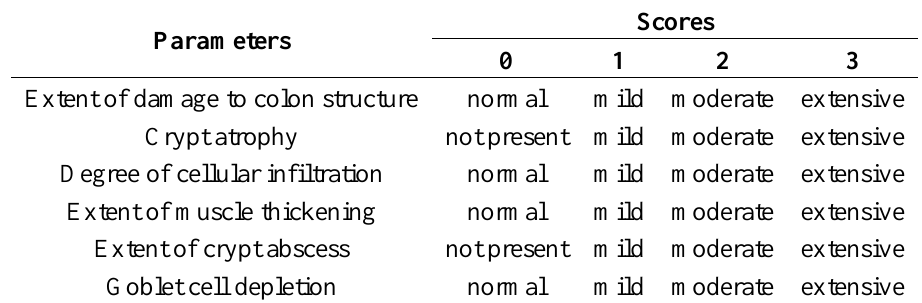
Table 1. Parameters and scores used to assess damage in the colon tissues of